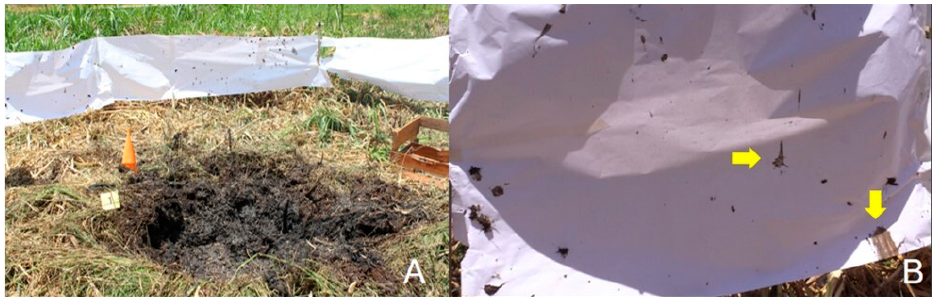
Figure 6. ( A ) Overview of the scattering patterns of the blast-driven particles of soil on the fence; ( B ) Close-up view shows different patterns of humid soil particles on the fence (yellow arrows).